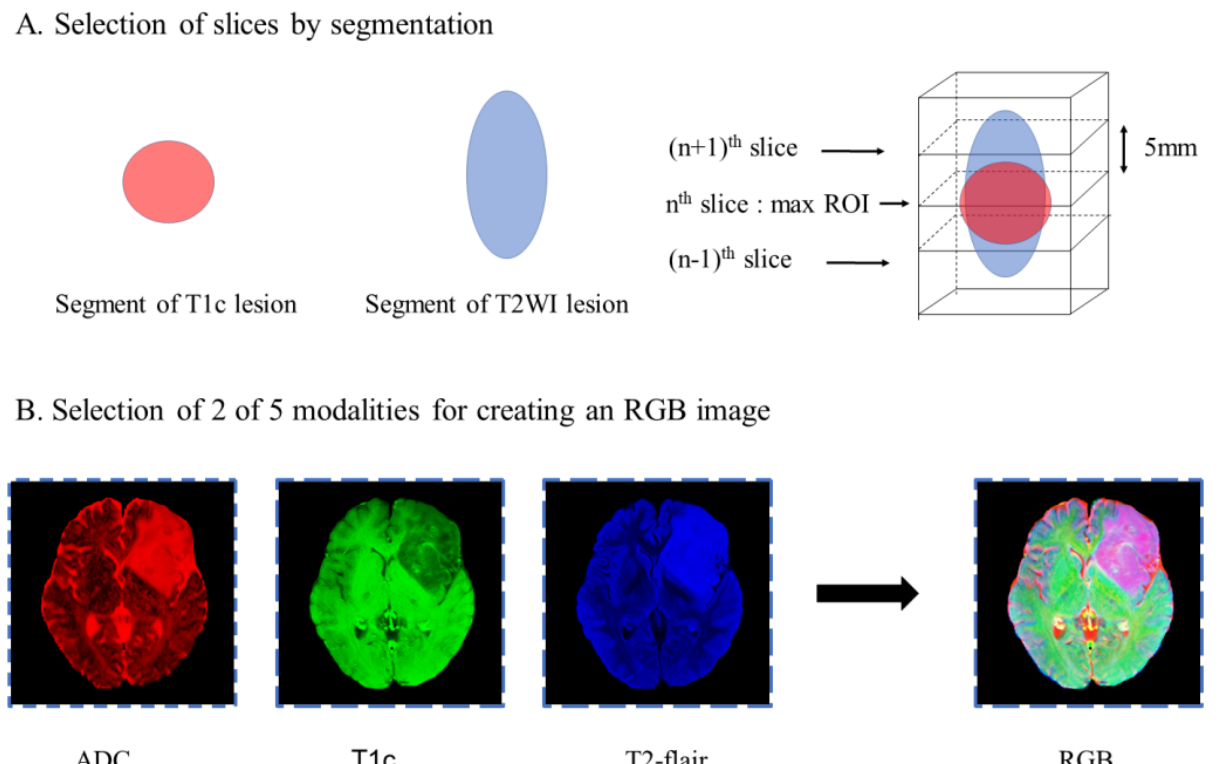
Figure 2. Schematic depicting the image processing strategy. ( A ) The largest tumor area and two adjacent layers 5 mm apart in the axial direction were selected using segmented contrast-enhancing (CEL) or T2 lesions (T2L). ( B ) Three of the four sequences of interest (T2-FLAIR, T1c, T2, and ADC) were placed in the red (R), green (G), and blue (B) channels of a color image that was used as the input to the network.